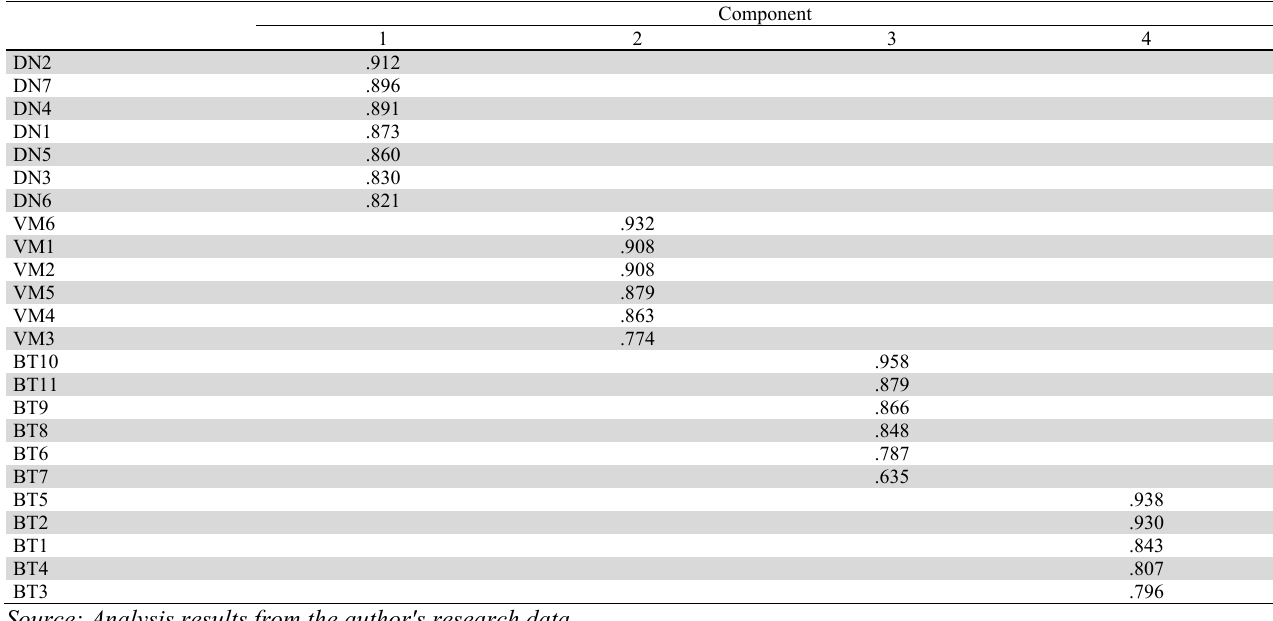
Rotated Factor Matrix